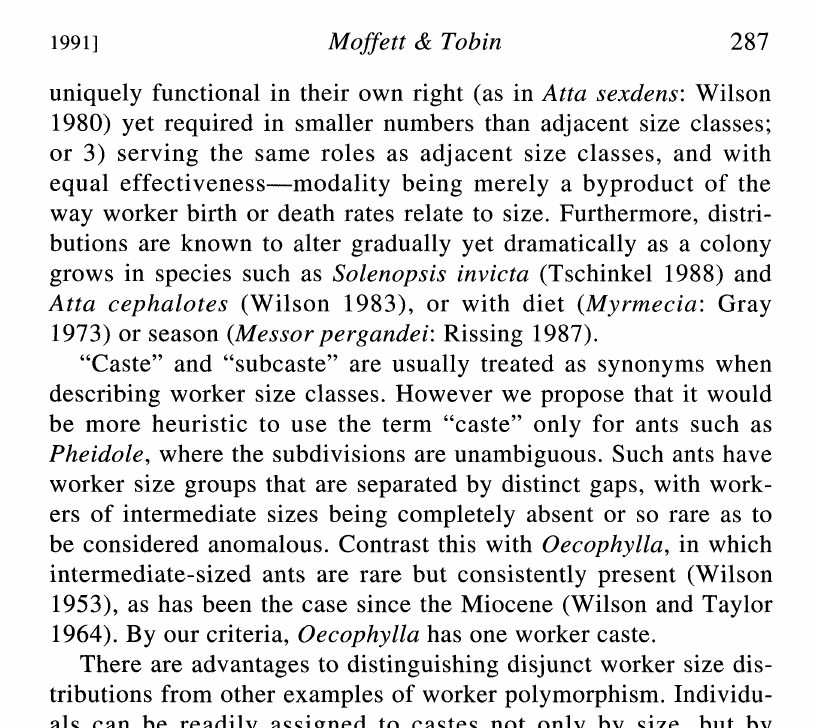
Fig. 2 (opposite). Worker allometry (head width vs. eye to occipital lobe dis- tance: top) and worker size-frequency distribution (bottom) in a Daceton armigerum colony. While the species is clearly polymorphic (the slopes of allomet- ric regression lines differ substantially from unity), worker allometry is consistently monophasic; in the example given, eye-lobe distance equals-0.347 * (Head width) 0"592 with 0.989. Also, the size distribution is unimodal. Numbers in bar graph indicate numbers of ants of each head width in the sample. Scanning electron micrographs of minor, media and major worker subcastes are shown at identical